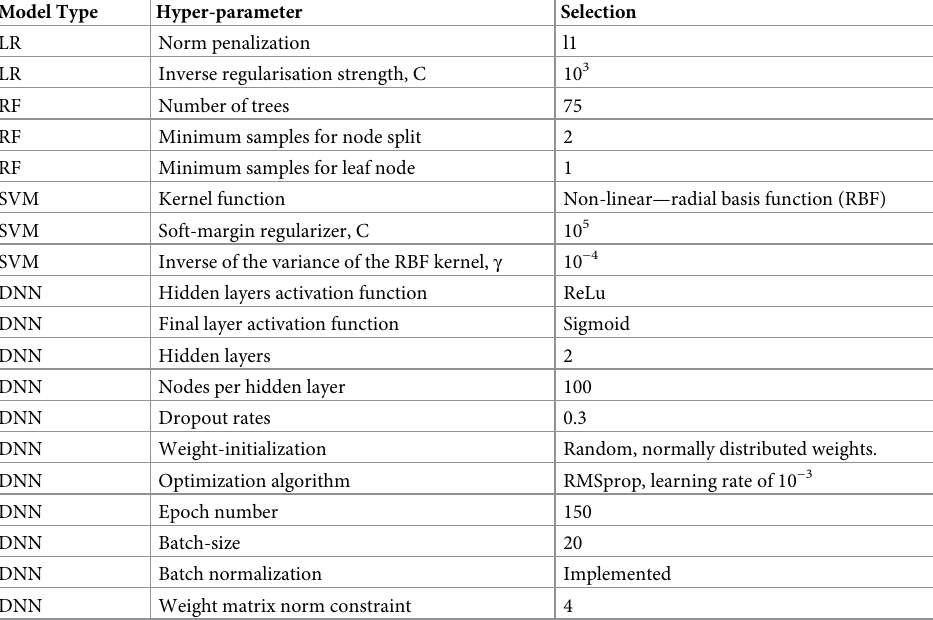
Table 3. Model hyperparameters. Table detailing the LR, RF, SVM and DNN models’